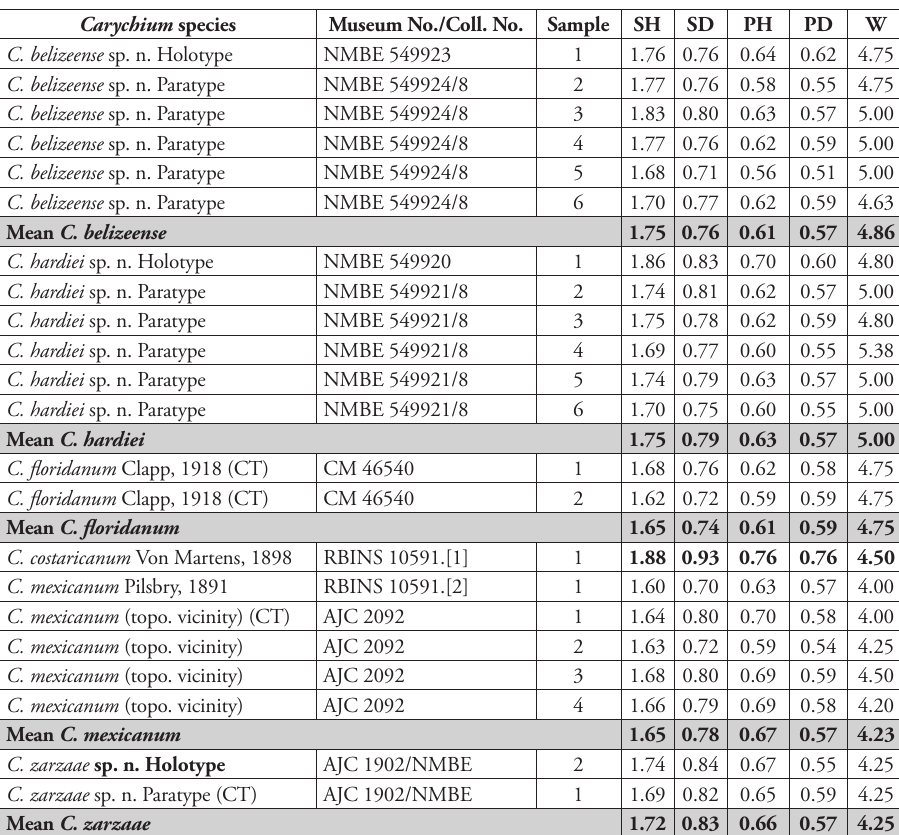
Table 2. Measurement of Carychium shells in frontal view. Species: Carychium belizeense sp. n., N = 6; Carychium hardiei sp. n., N = 6; Carychium floridanum Clapp, 1918 (CN 46540), N = 2;